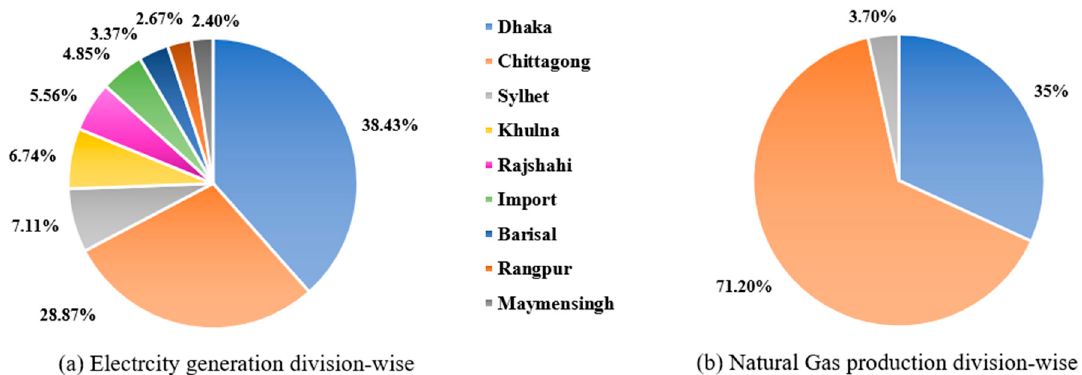
Figure 11. Electricity and natural gas production share division-wise based on currently active gas production fields (excluding condensate gas data) [49,50].